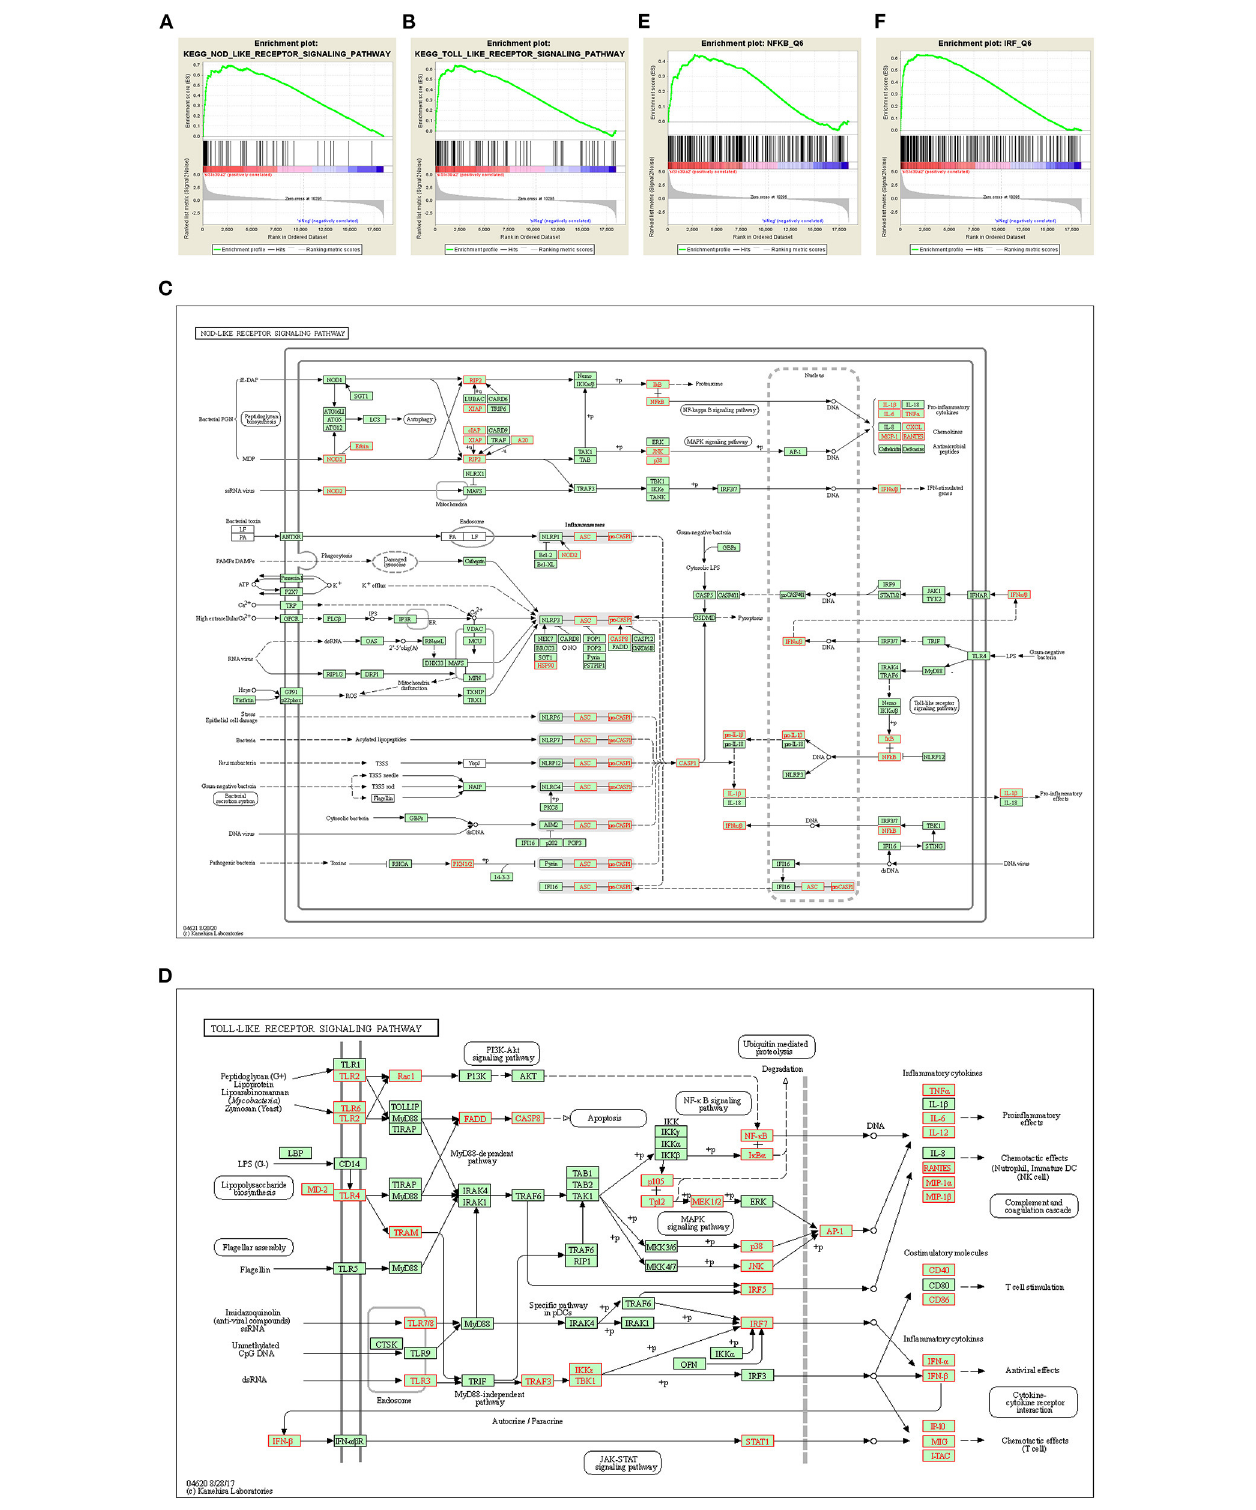
FIGURE 5 | Slc39a2 deficiency activates innate immune signaling during cardiomyocyte hypertrophy. (A,B) Gene set enrichment analysis (GSEA) identified NOD-like receptor (A) and TOLL-like receptor (B) pathways to be significantly enriched by Slc39a2 knockdown. (C,D) KEGG analysis showing the siSlc39a2-affected genes involved in NOD-like receptor (C) and TOLL-like receptor (D) pathways. (E,F) GSEA identified NF κ B and IRF as key factors involved in siSlc39a2-mediated transcriptome reprogramming.